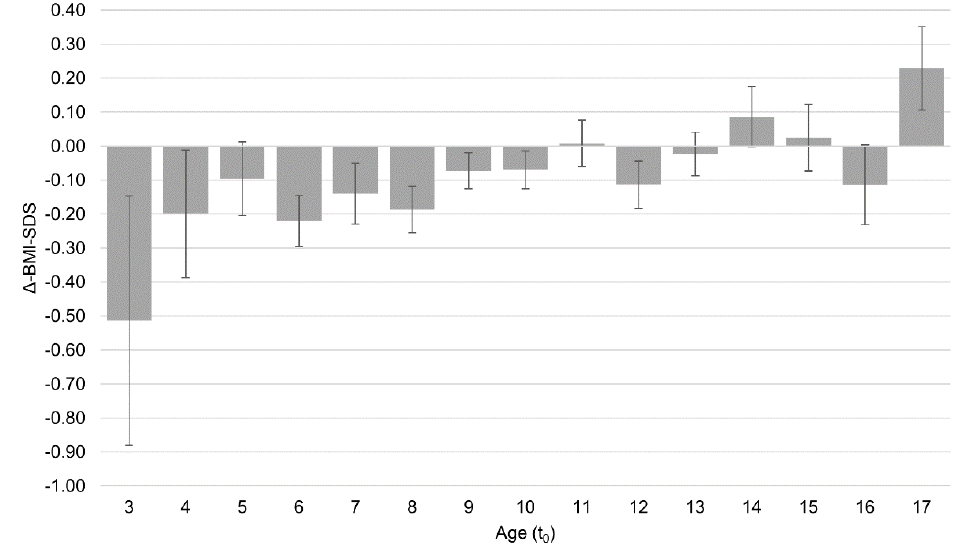
Figure 1. Patient age at treatment initiation (t 0 ) and BMI-SDS reduction ( M ± S.E. ) at end of treatment (t 1 ) (Intent-to-treat sample with multiple imputation, n = 361). BMI-SDS = Body Mass Index-Standard Deviation Score; M = mean; S.E. = standard error of mean.